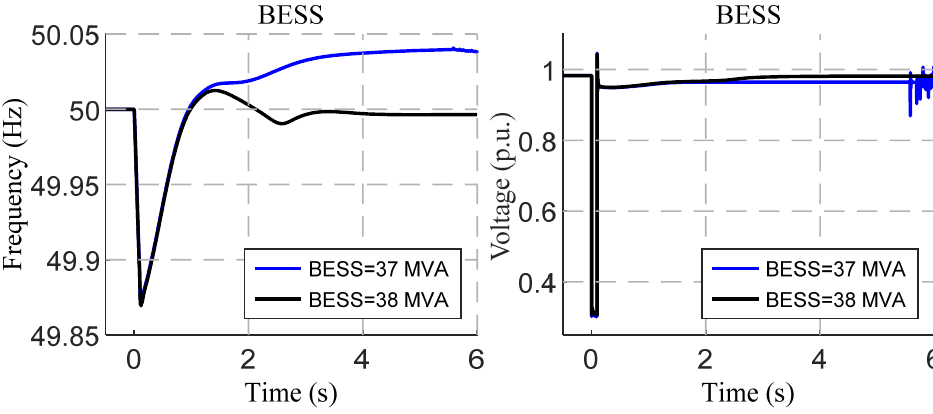
Figure 10. BESS power converter active and reactive power outputs—base case scenario.